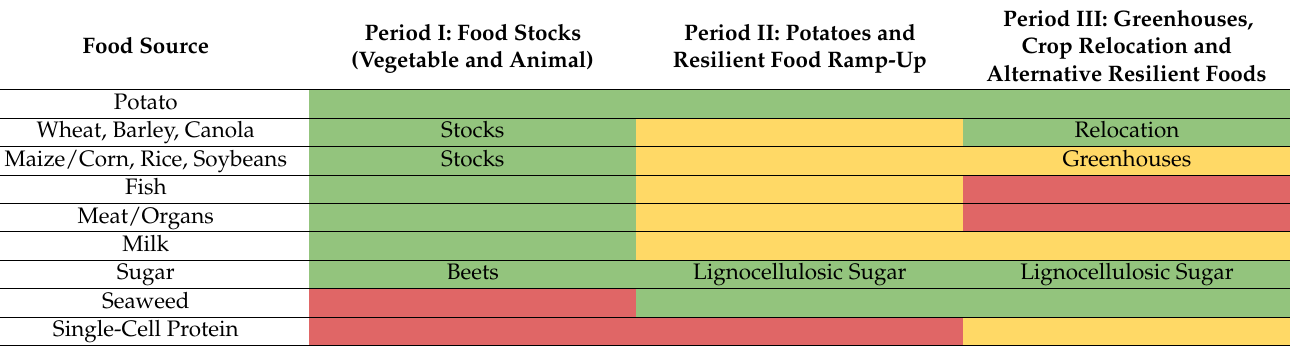
Table 1. Proposed chronology of resilient foods’ availability—in red: not available in significant quantities; in yellow: possibly available in significant quantities; in green: available. Each period is expected to last between 3 and 9 months.